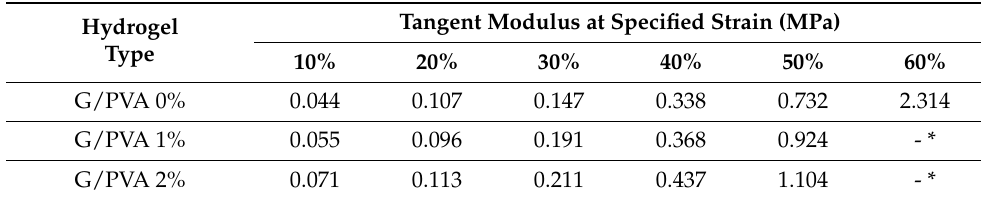
Figure 3. Compression stress–strain curve for a gelatin-based hydrogel without PVA (G/PVA 0%) ( a ), a gelatin-based hydrogel with 1% PVA (G/PVA 1%) ( b ), and a gelatin-based hydrogel with 2% PVA ( c ) and a comparison of the representative stress–strain characteristics for all hydrogels tested ( d ). In each case, the concentration of gelatin was 10% w / v . Table 1. Tangent modulus of gelatin and gelatin/PVA-based hydrogels determined at a given strain value for one representative sample of each type of material.